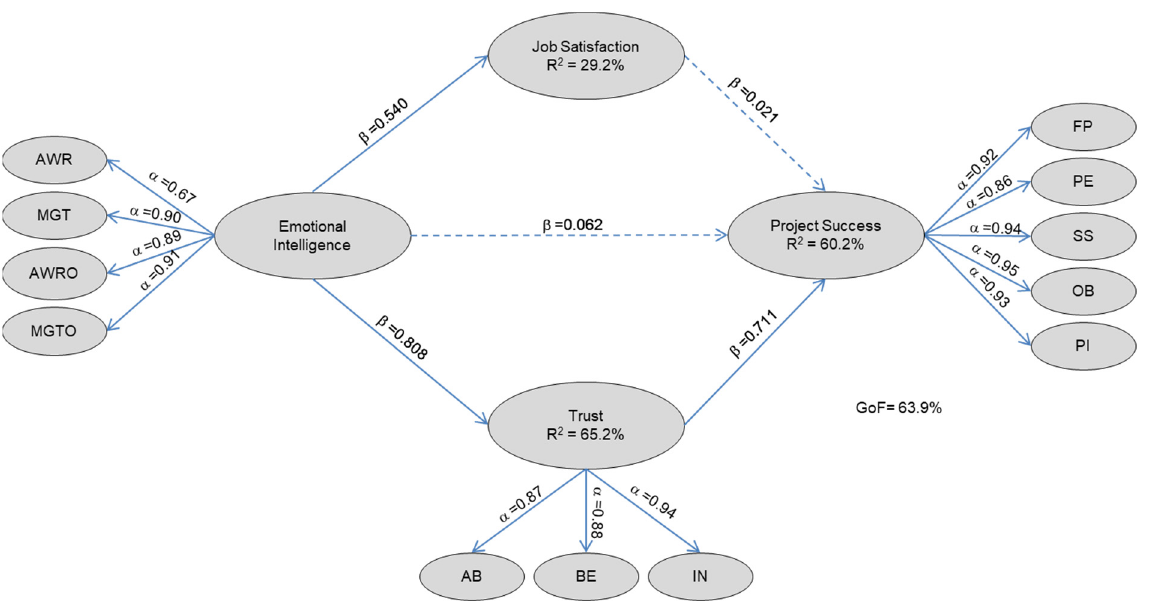
Figure 1. Path Model with PLS analysis results.